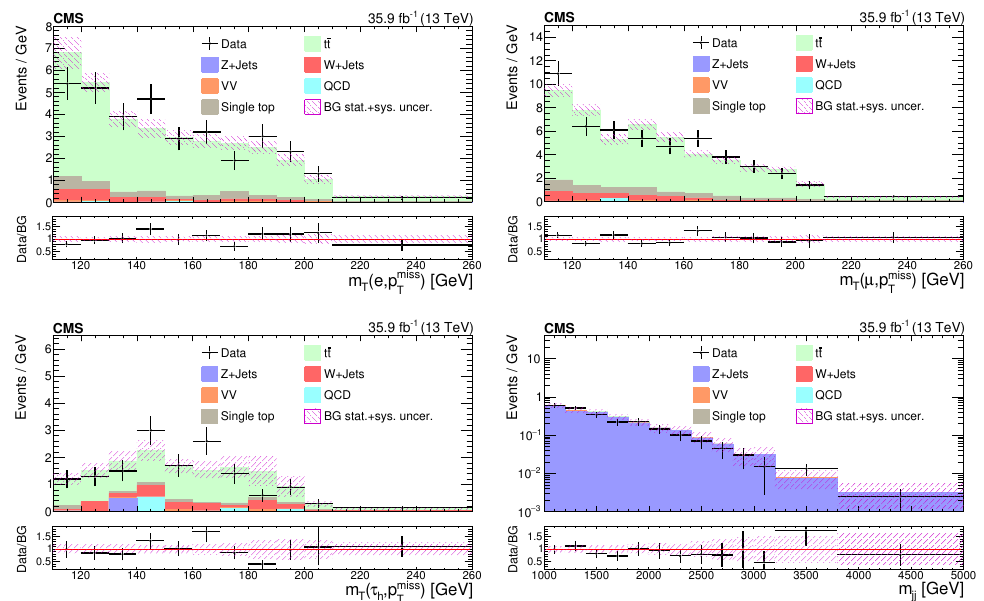
Figure 2 . The m and (lower left) CR1